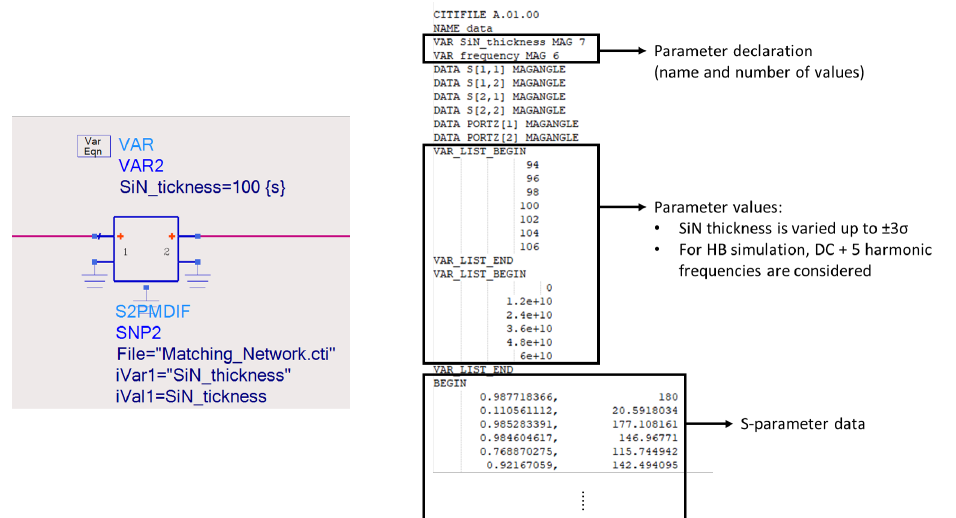
Figure 6. MDIF file used for passive structures as a function of T SiN . ( Left ): circuit symbol; ( right ): rel- evant part of the ADS citifile used.